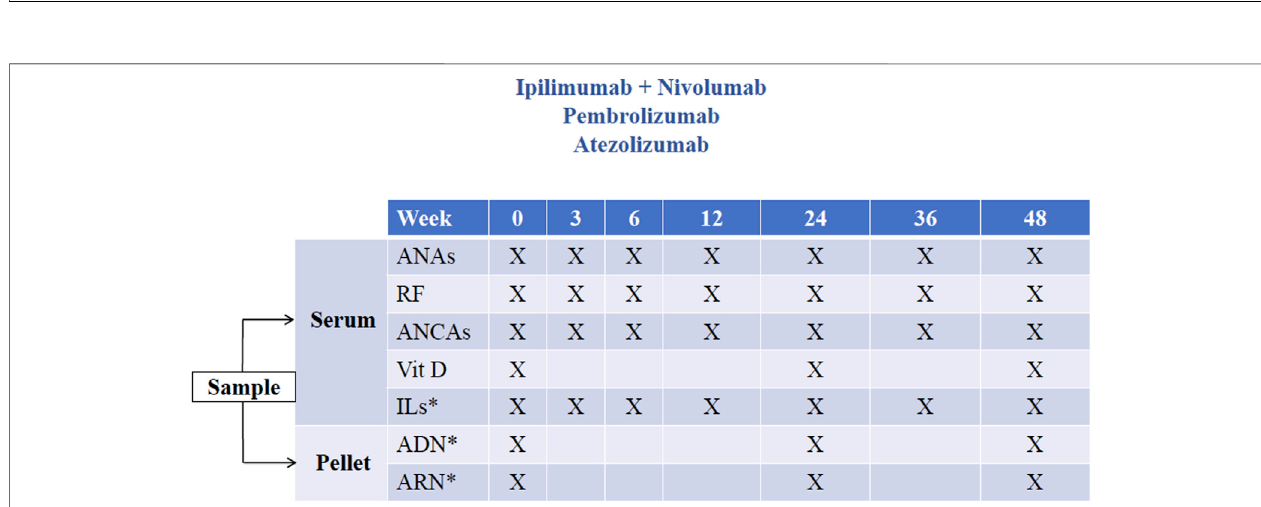
FIGURE 2 | Study schedule 2. Timing of ordinary samples for patients included receiving immune checkpoint inhibitors or combinations of immune checkpoint inhibitorsadministeredevery3 weeks(ipilimumab+nivolumab,pembrolizumabandatezolizumab).*Measurementsnotincludedinthisstudy(potentiallyforuseinfuture research projects). ANA, antinuclear antibody; RF, rheumatoid factor; ANCA, antineutrophil cytoplasmic antibody; Vit D, vitamin D (measured as 25- hydroxycholecalciferol); IL, interleukin.